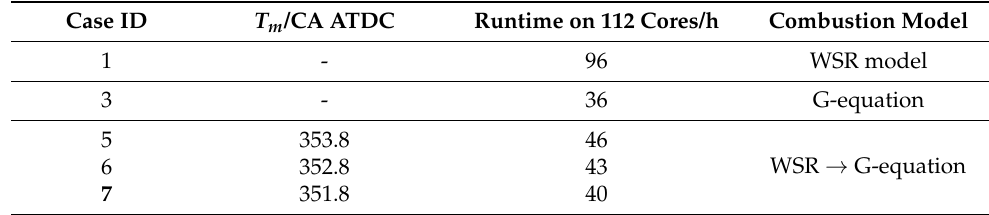
Table 6. T m and the case simulation time cost.